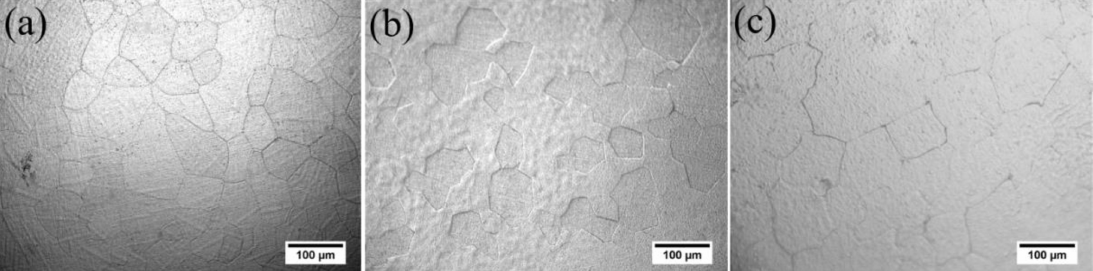
Figure 3. The optical images of the STed samples of ( a ) TZT1, ( b ) TZT2 and ( c ) TZT3 alloys.